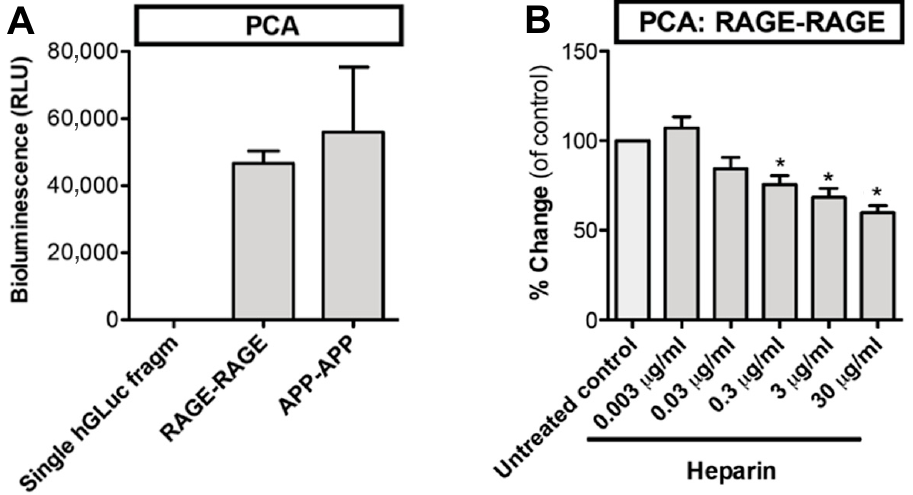
Figure 2. Homophilic interactions of RAGE on the living cell surface are inhibited by heparin. ( A ) Cells were transfected with full length RAGE–cytoplasmic hGLuc fragment chimeras. RAGE self-association was measured with luciferase activity. hDLuc fragment chimeras of APP served as a positive control of homodimerization. ( B ) RAGE self-association was partially inhibited by heparin. N = 3–4; error bars represent ± SD. * = p < 0.05 when compared with untreated control. hGLuc = humanized Gaussia luciferase, RLU = relative light unit, PCA = protein-fragment complementation assay, APP = amyloid β .